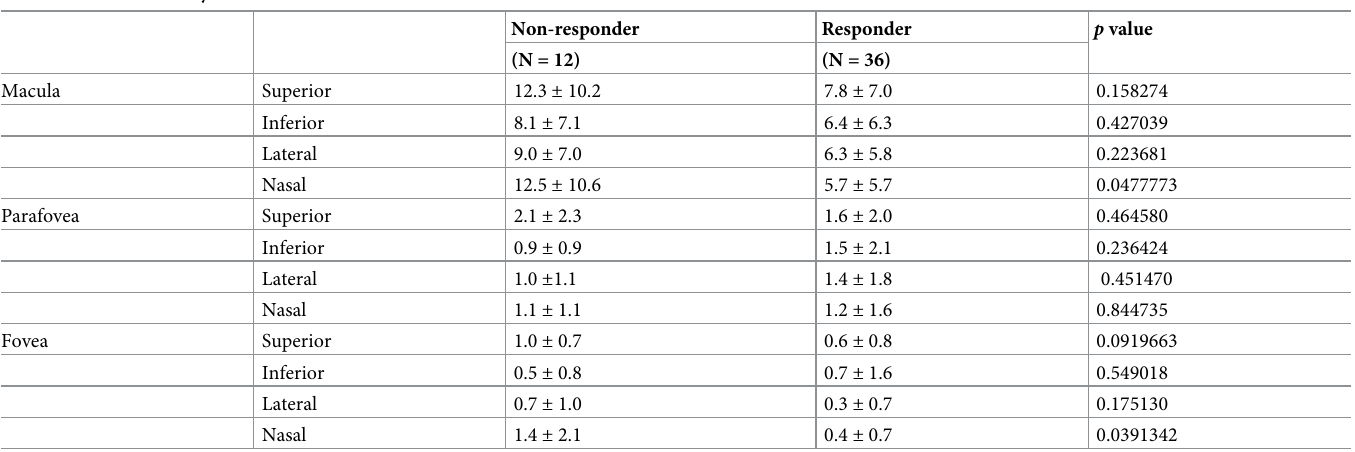
Table 4. Detected MA by IA.